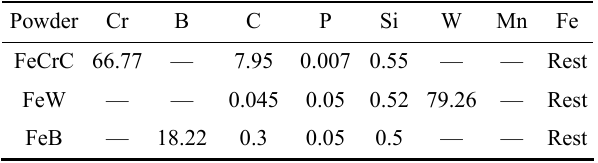
Fig. 1 Machined substrate materials dimensions. Reproduced with permission from Ref. [33], © Firat University, 2017. Table 1 Chemical compositions of ferroalloy powders. (wt%)